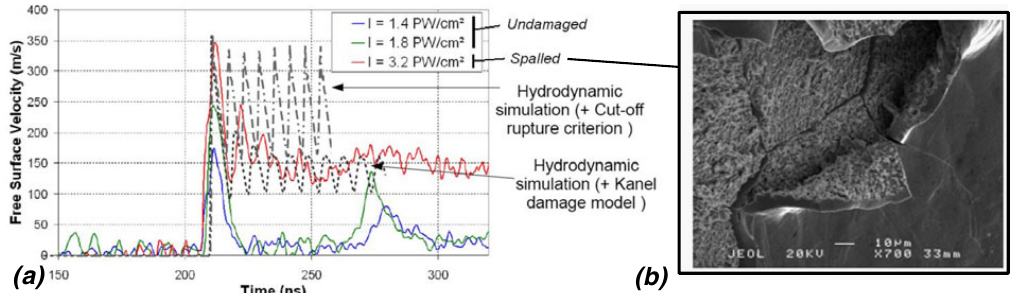
Fig. 3. Experimental free surface velocities of laser shocked 100 μ m tantalum targets for di ff erent intensities – Numerical Kanel & Cut-o ff fitting (3a) ; SEM picture of the damaged free surface corresponding to the highest intensity on the 3a graph